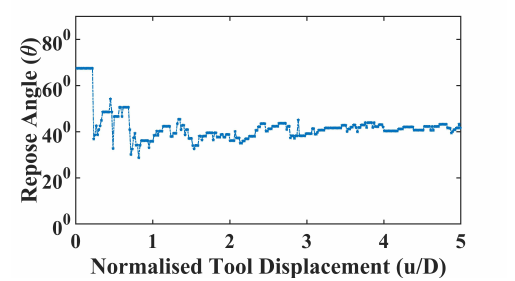
Figure 4. Evolution of repose angle as a function of tool displacement